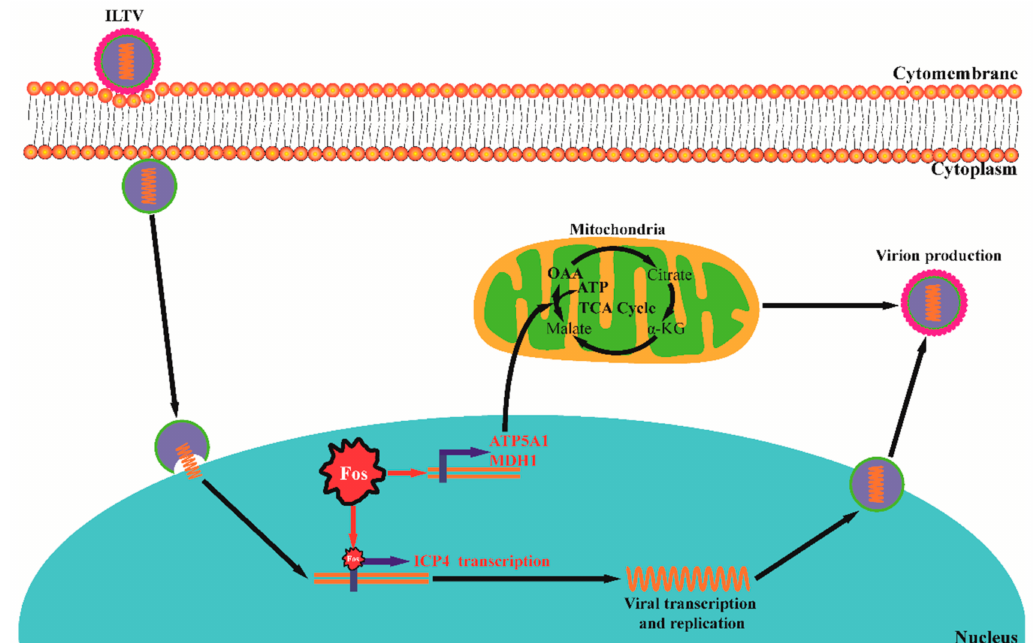
Figure 6. A schematic presentation of the two mechanisms by which Fos facilitates ILTV infection. On the host side, Fos maintains the supplies of OAA and ATP for viral gene transcription and subsequent processes of viral proliferation by controlling the transcription of ATP5A1 and MDH1 ; on the virus side, Fos binds directly to the promoter of the viral IE gene ICP4 to initiate viral transcription. The color of the arrow indicates the flux changes, and the font colors denote gene-level changes (red-direct promoted, black-no effect). α -KG: oxoglutarate, OAA: